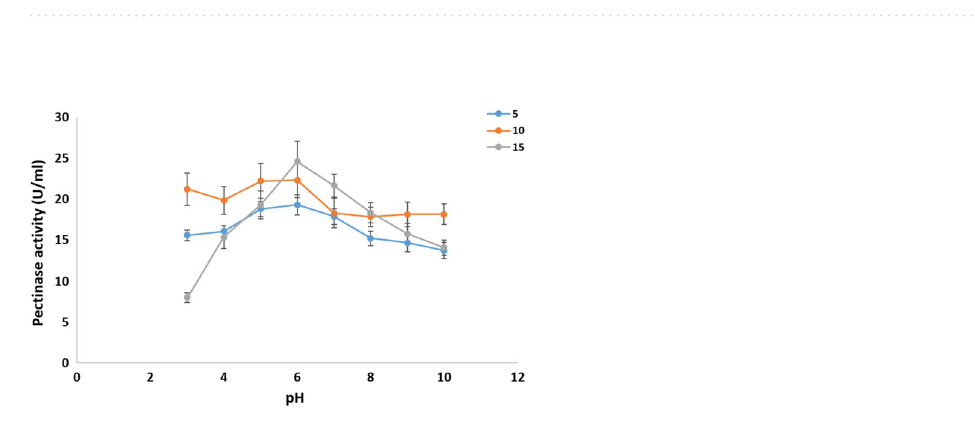
Figure 7. Effect of pH at 5, 10, and 15 °C on the pectinase production by Cladosporium parasphaerospermum AUMC 10865.